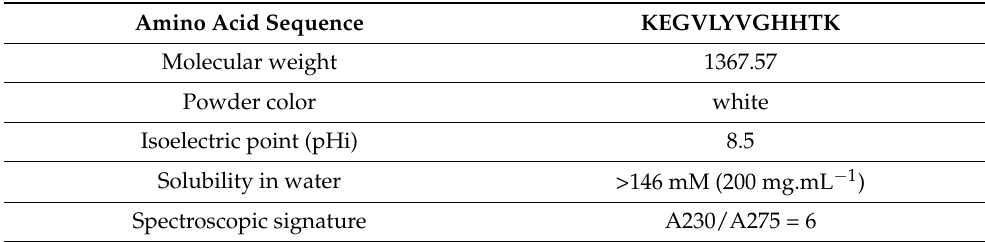
Table 1. Physicochemical properties of